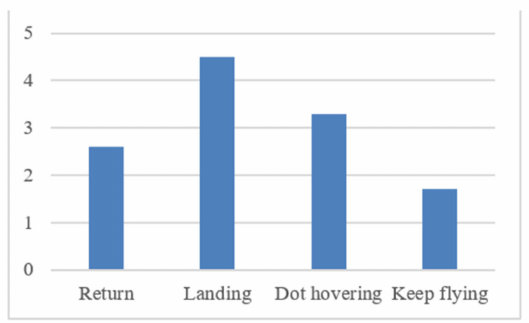
Figure 4. Decision result based on real-time attribute